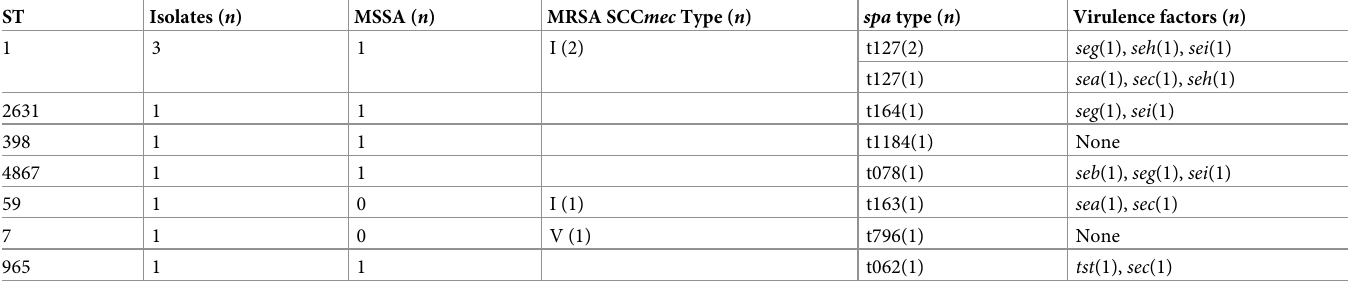
ST, sequence type by multi-locus sequence typing; SCC mec , Staphylococcal cassette chromosome mec ; spa , Staphylococcus protein A gene; None, no virulence gene